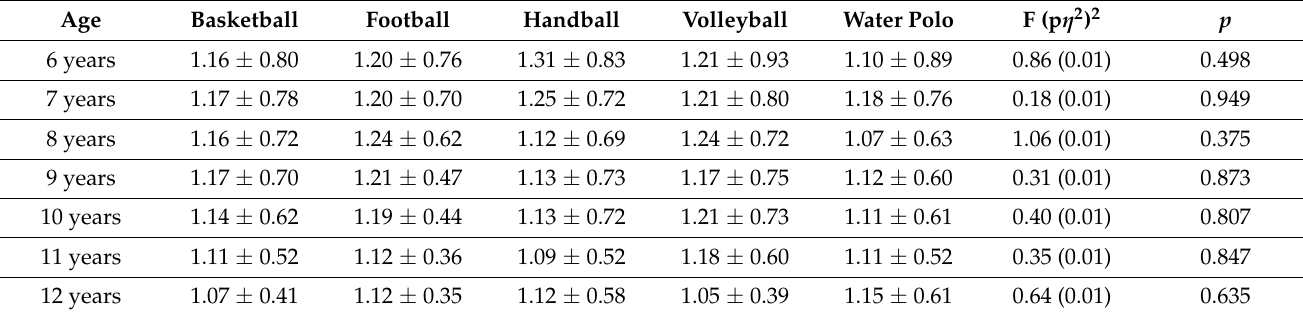
Table 2. Number of sports practised according to age and sport.